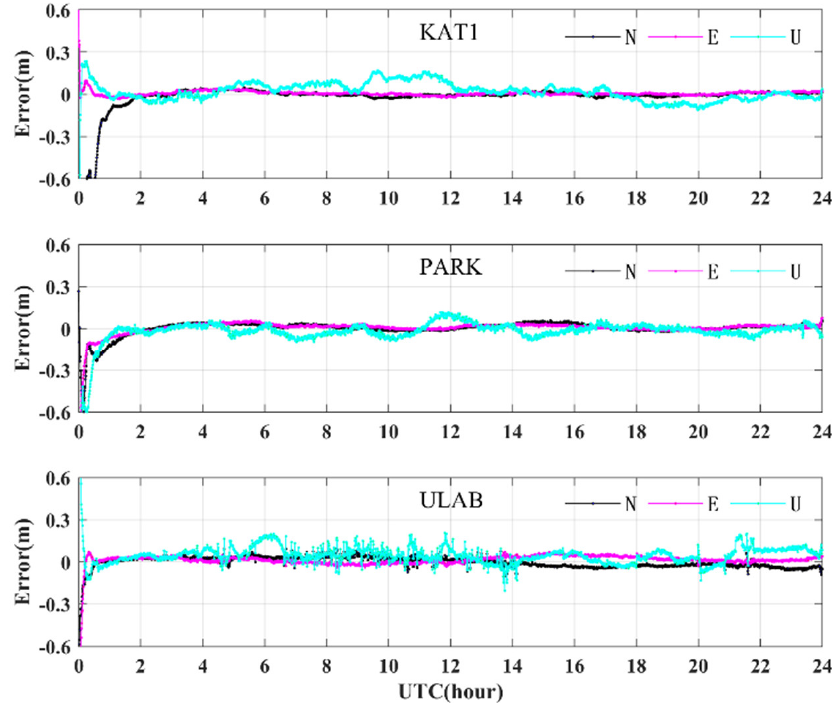
Figure 17. Kinematic PPP results using clock offset estimated in Asia-Pacific.